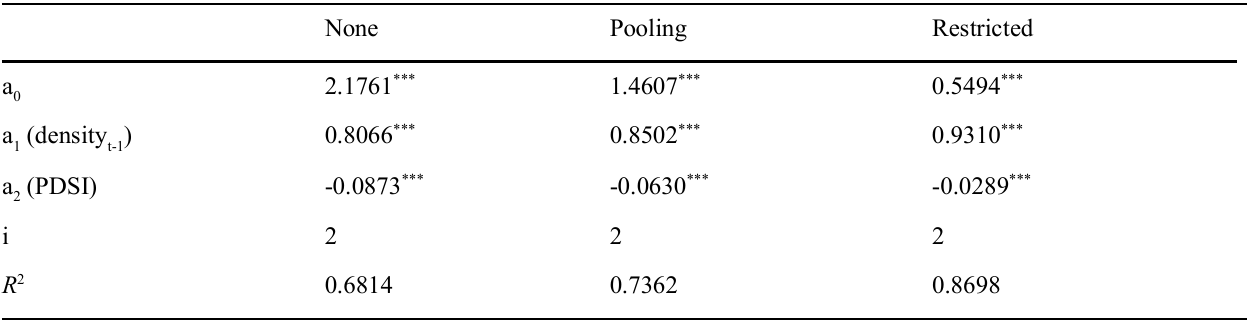
Table 3. Results of linear regressions for three types of